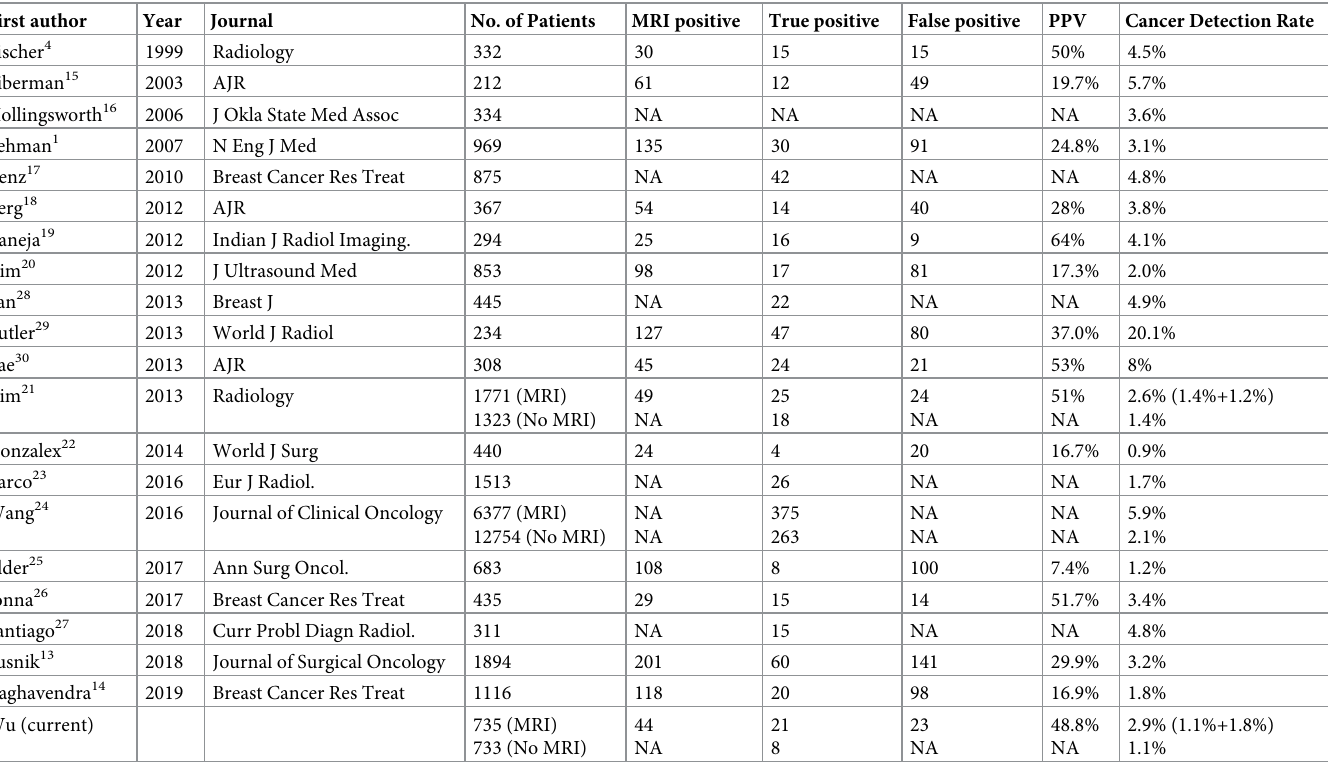
Table 3. Published studies documenting pre-operative MRI Evaluation of the contralateral breast in women with newly diagnosed breast